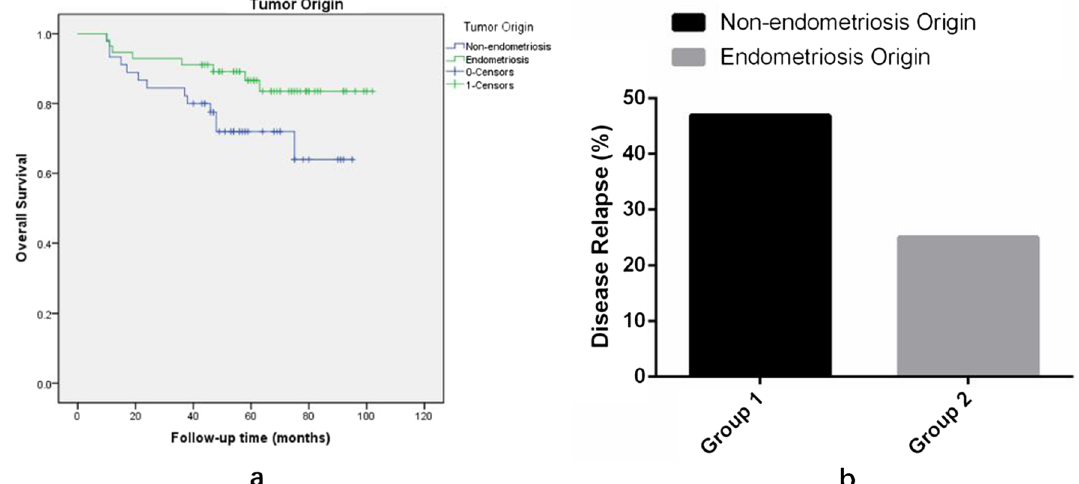
Fig. 4 a Survival curves of prognostic factors for overall survival by Tumor origin; b . The proportion of patients with disease relapse in Group 1 (non-endometriosis origin) and Group 2 (endometriosis